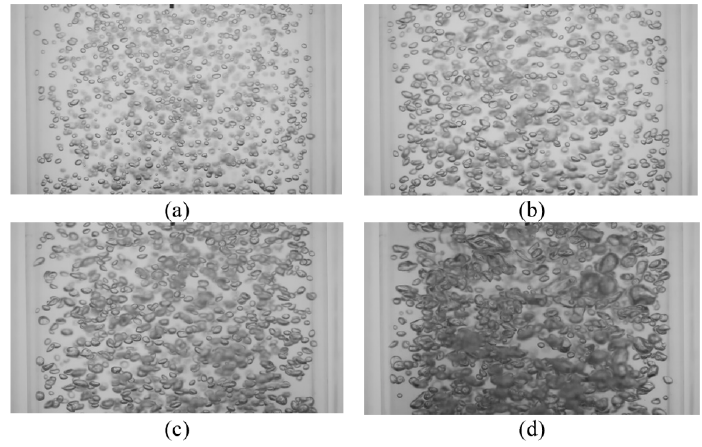
Figure 7. Instantaneous images of bubble mixing at t = 8 s for ( a ) U SG = 13.8 mm/s, ε = 2.5%; ( b ) U SG = 27.6 mm/s, ε = 3.3%; ( c ) U SG = 41.4 mm/s, ε = 4.2%; and ( d ) U SG = 55.2 mm/s, ε = 5.9%.